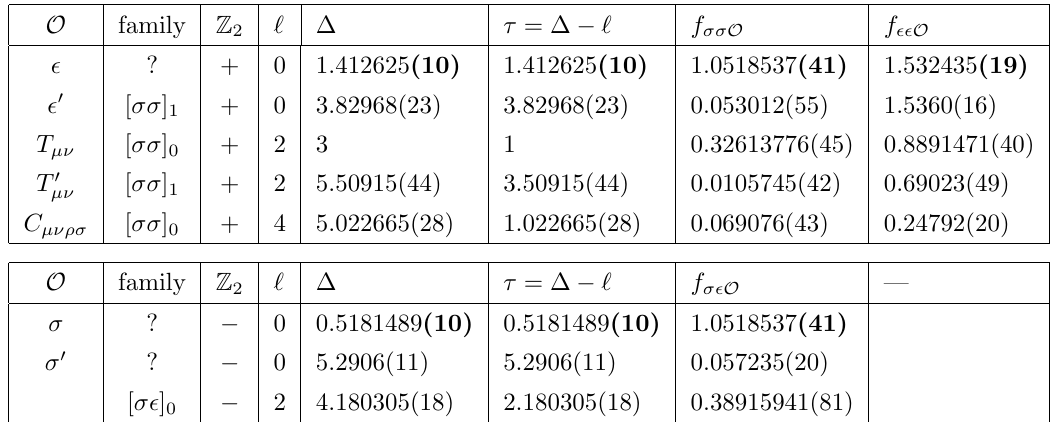
Table 1 : A few low-dimension operators in the 3d Ising CFT, from [10]. The \?" are associated to scalars whose a(cid:14)liation with a certain operator family is not fully established. Errors in bold are rigorous. All other errors are